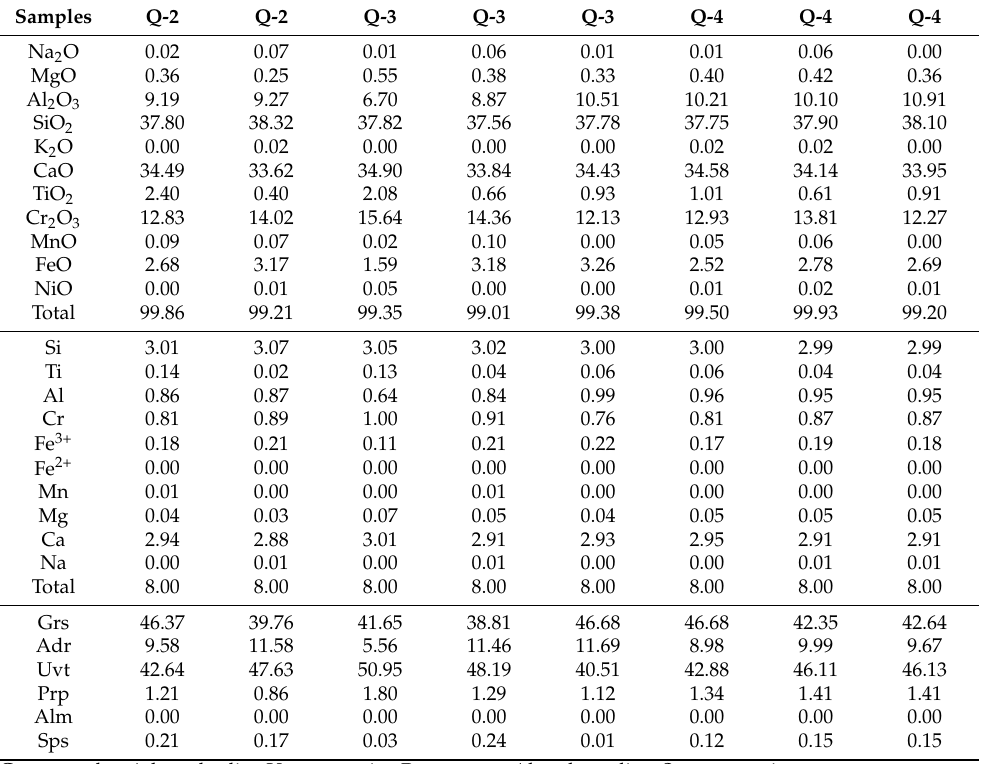
Table 3. Chemical compositions of the garnet-supergroup mineral (wt.%).